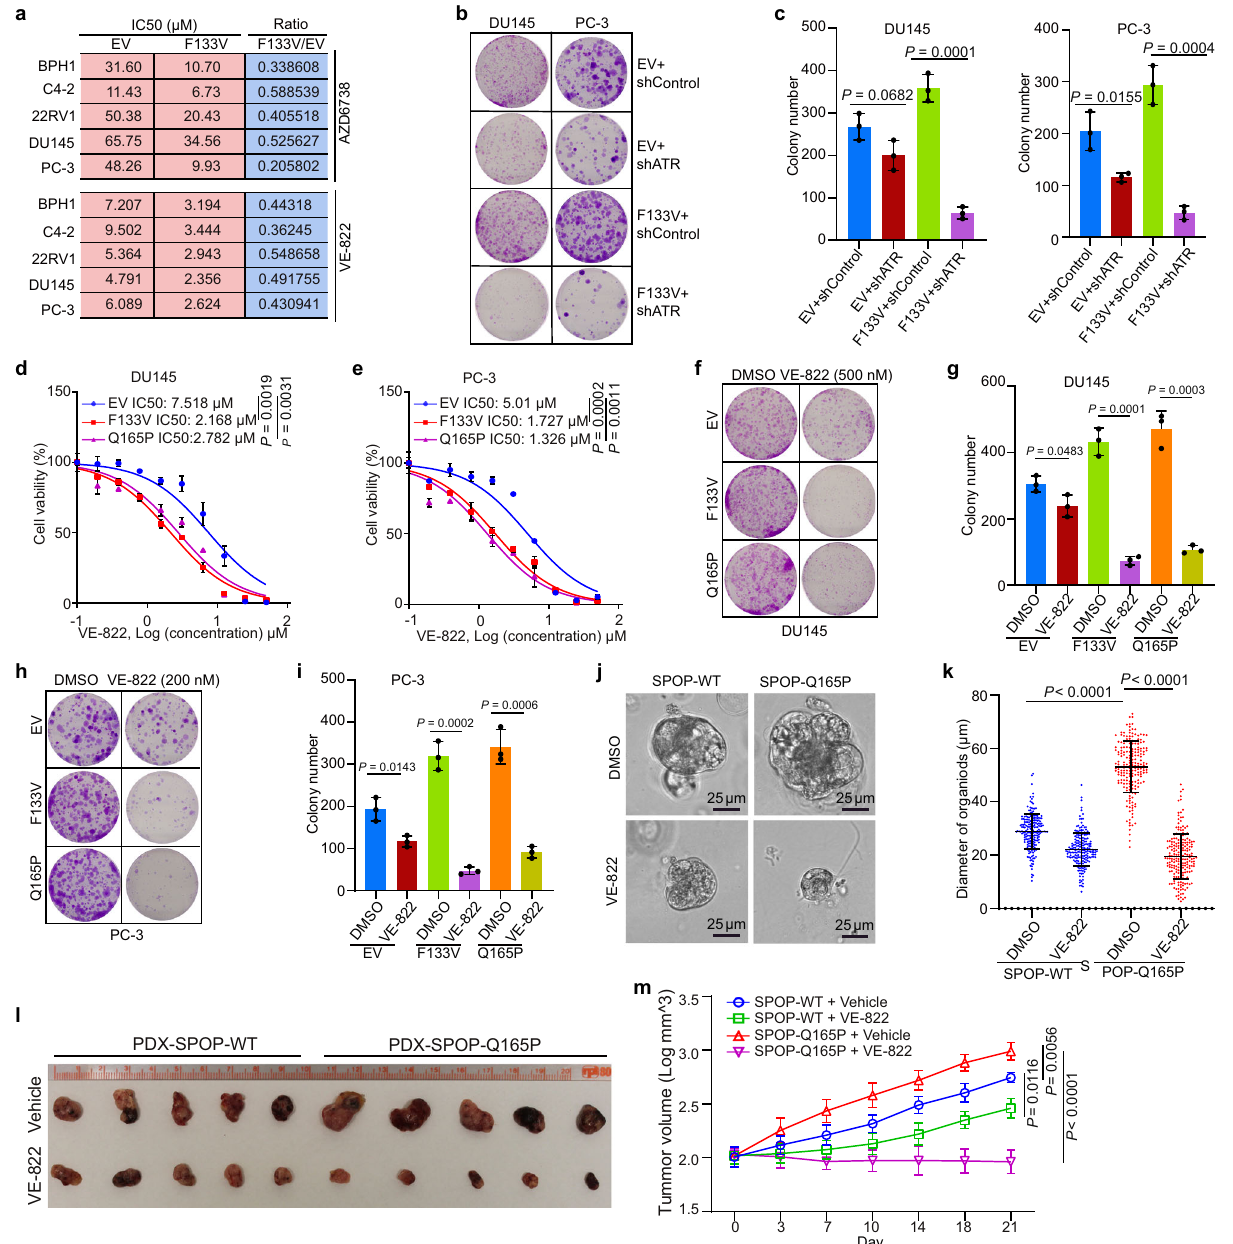
Fig. 6 SPOP mutant cells are sensitive to ATR pathway inhibition. a IC50 analysis of two ATR inhibitors in fi ve prostate cell lines expressing EV or SPOP- F133V mutant. b , c Colony formation assays were performed in DU145 and PC-3 cell lines infected with lentivirus expressing control or ATR-speci fi c shRNA or empty vector (EV) or SPOP mutant F133V. The number of colonies was counted. Representative colonies are shown in ( b ) with quanti fi cation data shown in ( c ). Data are presented as the mean ± SD of three independent experiments. Two-tailed unpaired Student ’ s t -test. d , e Dose-response survival curves of EV, SPOP F133V, and SPOP Q165P cells exposed to increasing concentrations of VE-822 in DU145 ( d ) and PC-3 ( e ) cells. Data are shown as the mean ± SD of three independent experiments ( n = 3 replicates/group). Two-tailed unpaired Student ’ s t -test. f – i Colony formation assay was performed in DU145 ( f , g ) and PC-3 ( h , i ) cell lines treated with DMSO or VE-822. The number of colonies was counted. Representative colonies are shown in ( f , g ) with quanti fi cation data shown in ( h, i ). Data are shown as the mean ± SD of three independent experiments (n = 3). Two-tailed unpaired Student ’ s t -test. j , k SPOP WT and Q165P organoid lines derived from Q165P PDX tumors were cultured for 5 days, followed by treatment with DMSO or VE-822 (200 nM) for fi ve more days. The representative images of organoids after the treatment are shown in ( j ) and the quanti fi ed data of the organoid diameter are shown in ( k ). All data are shown as mean ± SD ( n = 200). The P value was calculated using unpaired two-tailed Student ’ s t -test. l , m SPOP- WT or SPOP Q165P PDX tumors were transplanted subcutaneously into SCID mice and treated with VE-822 (60 mg/kg, 5 times weekly by oral gavage) or vehicle. Mice were treated for 3 weeks and then sacri fi ced. Xenograft tumors were isolated and are shown in ( l ). Log of quanti fi ed volumes of the tumors from ( l ) ( n = 5) are shown in ( m ). All data are shown as mean ± SD. The P value was calculated by two-way ANOVA analysis. Source data are provided in this